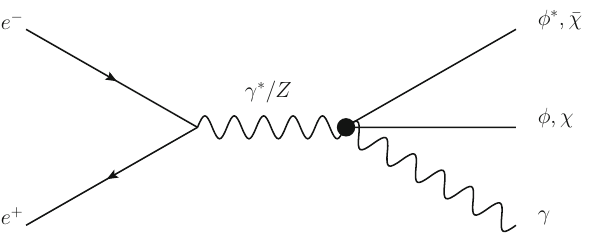
Fig. 1 DM production processes e + e − → φ ∗ φγ, ¯ χχγ with mono- γ channel. The s − channel Z will be on-shell during Z -pole runs at the CEPC